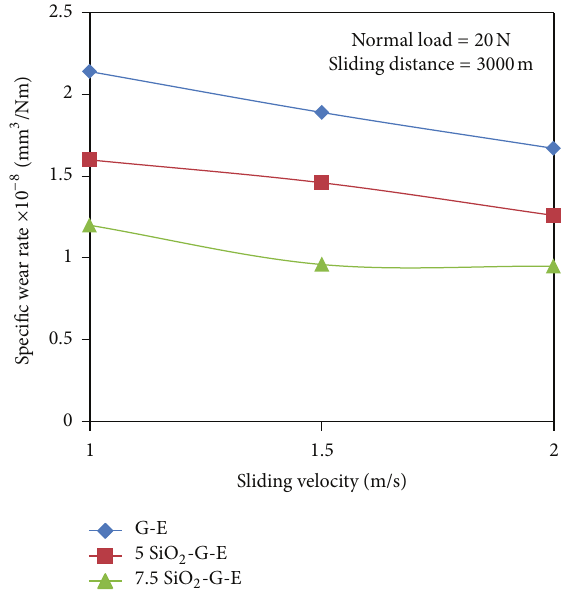
Figure 17: Specific wear rate of SiO 2 filled G-E